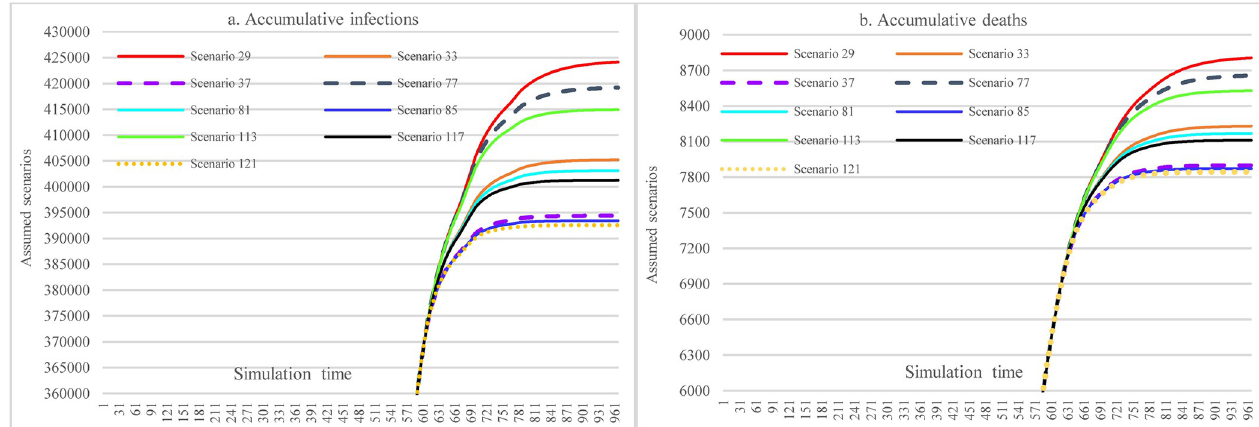
Fig 18. Impacts of changing vaccination levels and implementing social distancing measures with mask-wearing adherence level of 60%.